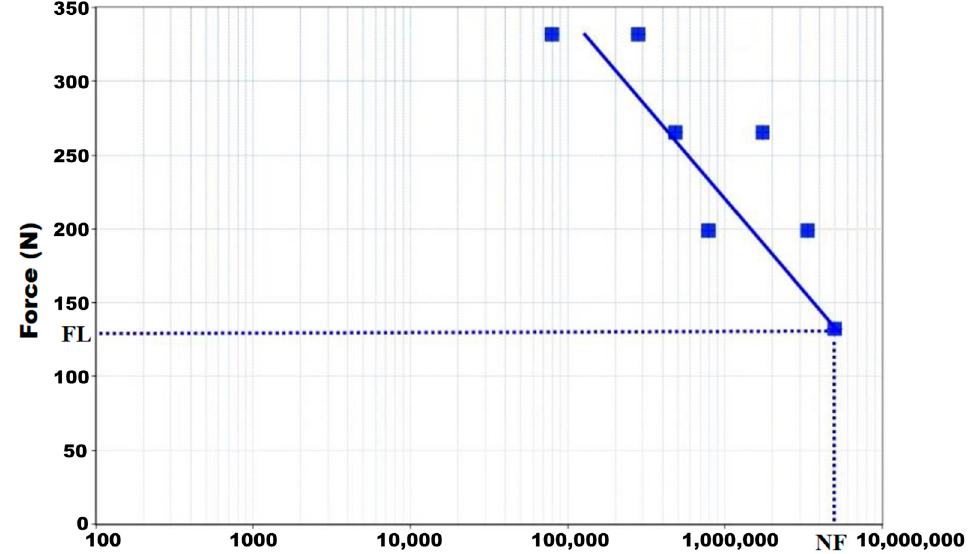
Figure 11. Load cycle diagram. LF: Fatigue limit. NF: Number of cycles without failure. In the geometric arrangement indicated in the ISO 14801:2017 standard, the maximum bending moment was 729.3 ± 69.43 mm/N. Table 2 shows the number of cycles the dental implant supported for each load. Table 2. The number of cycles supported by our dental implants for each load. Maximum Applied Load (N) Number of Cycles